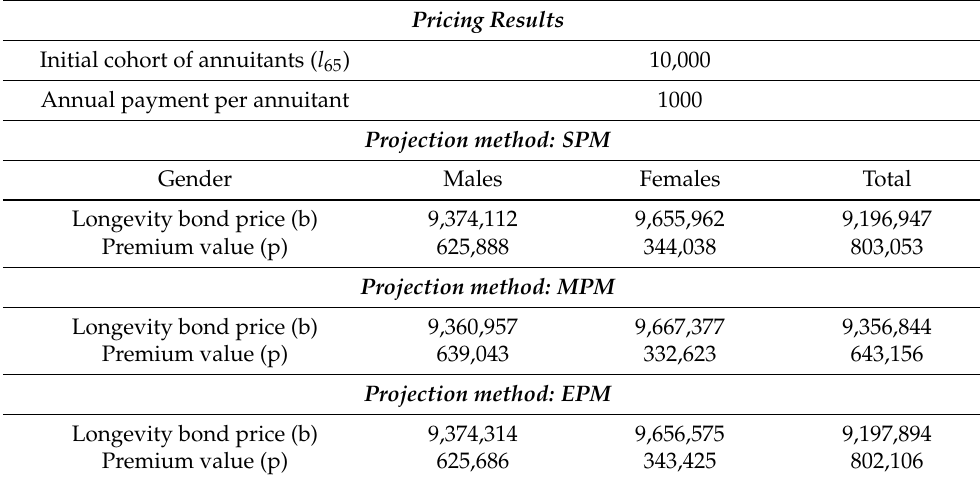
Table 2. Longevity bond pricing results under each projection method based on males, females, and annuitants from the total population of Greece.